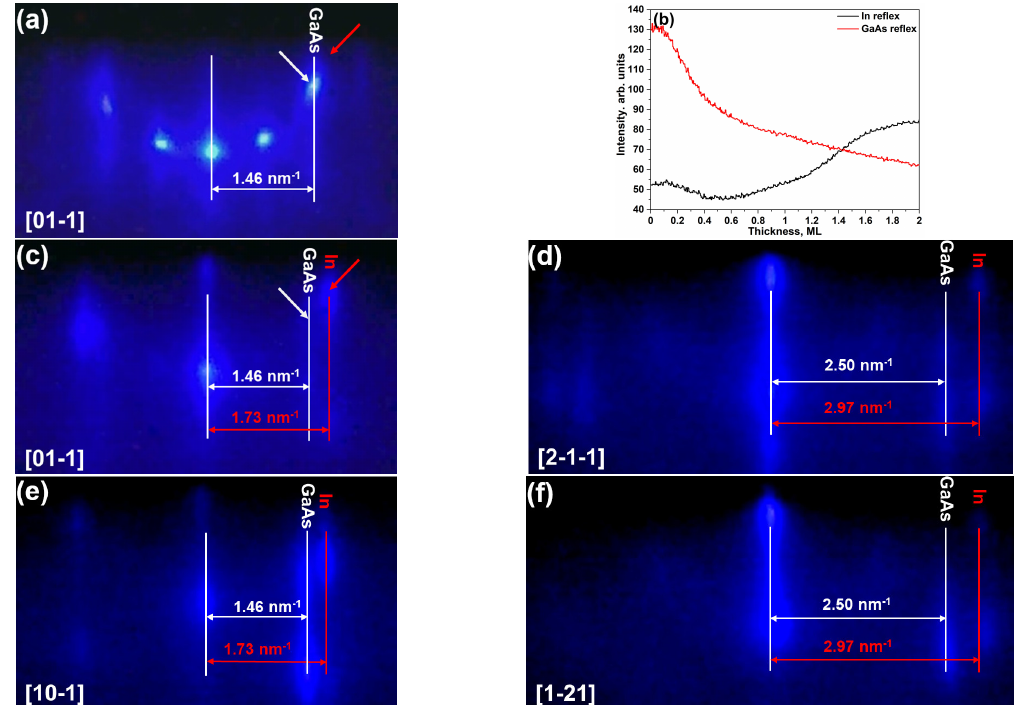
Figure 4. ( a ) RHEED pattern of GaAs buffer before the deposition of In. ( b ) The time dependence of the intensity of RHEED reflexes from GaAs and In taken along the [ 011 ] azimuth. RHEED patterns along ( c ) [ 011 ] , ( d ) [ 211 ] , ( e ) [ 101 ] , and ( f ) [ 121 ] azimuths after the deposition of 2 ML In on vicinal GaAs(111)A with 2 ◦ miscut towards ( 112 ) at 80 ◦ C. Red and white arrows correspond to points where the intensity dependence of In and GaAs reflexes, respectively, on panel (b) was